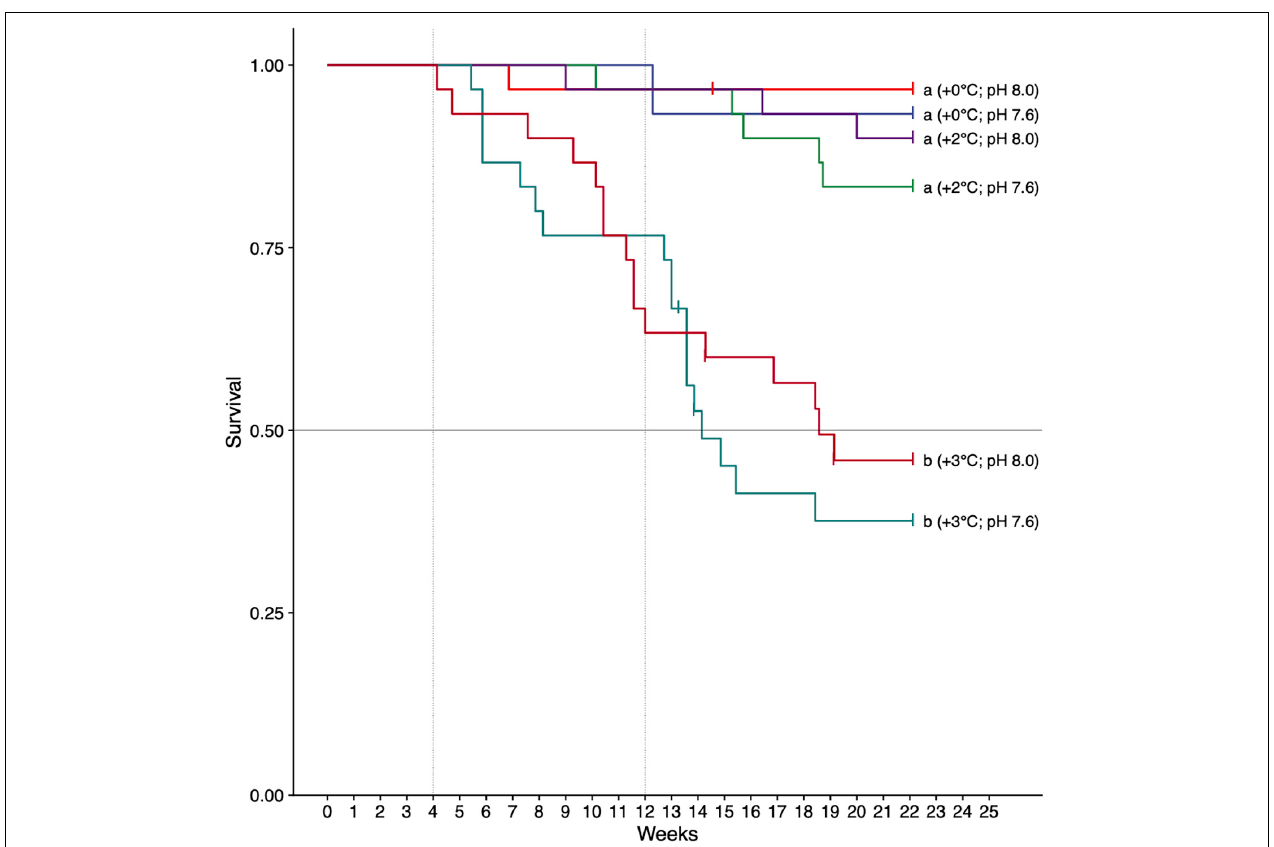
FIGURE 2 | Survival of H. erythrogramma acclimated to three temperature (ambient, +2 ◦ C, +3 ◦ C) and two pH T (8.0, 7.6) levels in six treatments. Letters indicate treatments that differed (pairwise tests, with Benjamini–Hochberg [BH] false discovery rate corrections, p < 0.05). The horizontal line is the median survival threshold; vertical lines show times of data collection at 4 and 12 weeks of